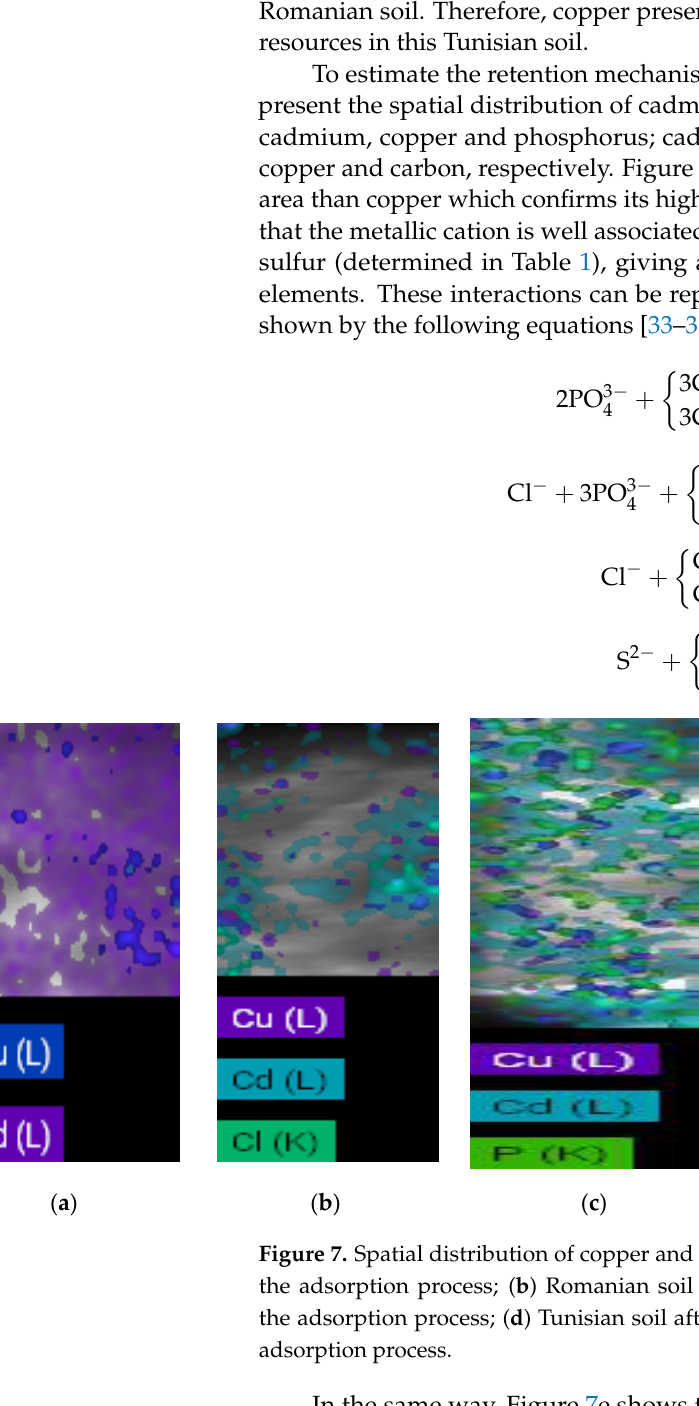
Figure 7. Spatial distribution of copper and cadmium in a different region: ( a ) Romanian soil after the adsorption process ; ( b ) Romanian soil before the adsorption process; ( c ) Tunisian soil after the the adsorption process; ( b ) Romanian soil before the adsorption process; ( c ) Tunisian soil after adsorption process; ( d ) Tunisian soil after the adsorption process ; ( e ) Tunisian soil before the ad- the adsorption process; ( d ) Tunisian soil after the adsorption process; ( e ) Tunisian soil before the sorption process. adsorption